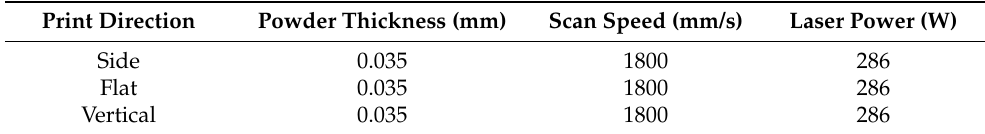
Table 3. The 316L stainless-steel sample printing process